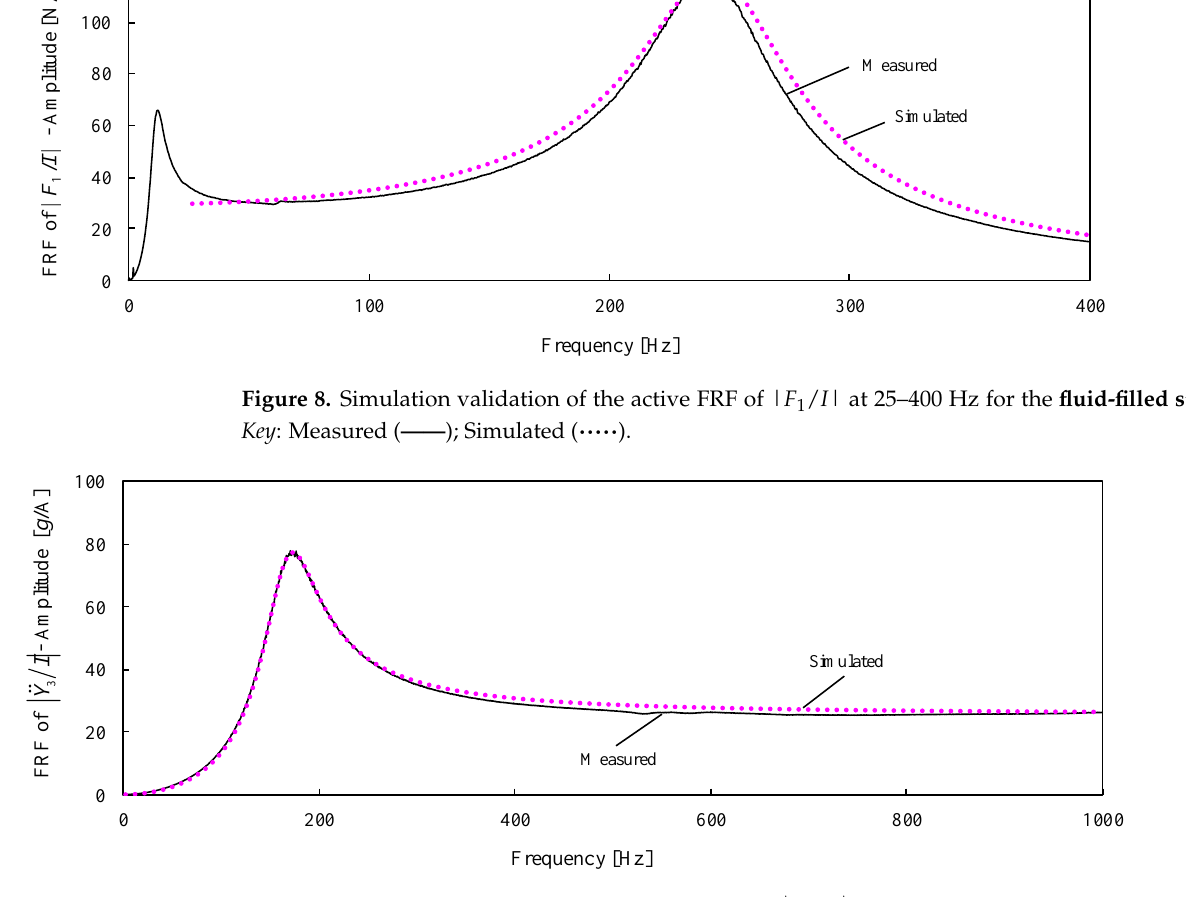
Figure 9. Simulation validation of the active FRF of Key : Added masses m ad = 8.90 g; Measured ( —— ); Simulated ( ····· ).